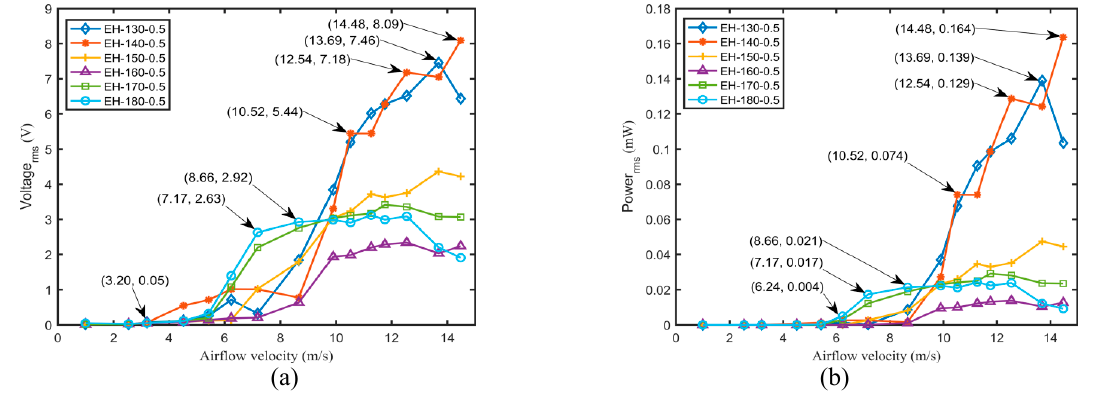
Figure 7. Variations of output voltage ( a ) and output power ( b ) with airflow velocity for various harvesters with a thickness of 0.5 mm and a resistance of 400 k Ω .